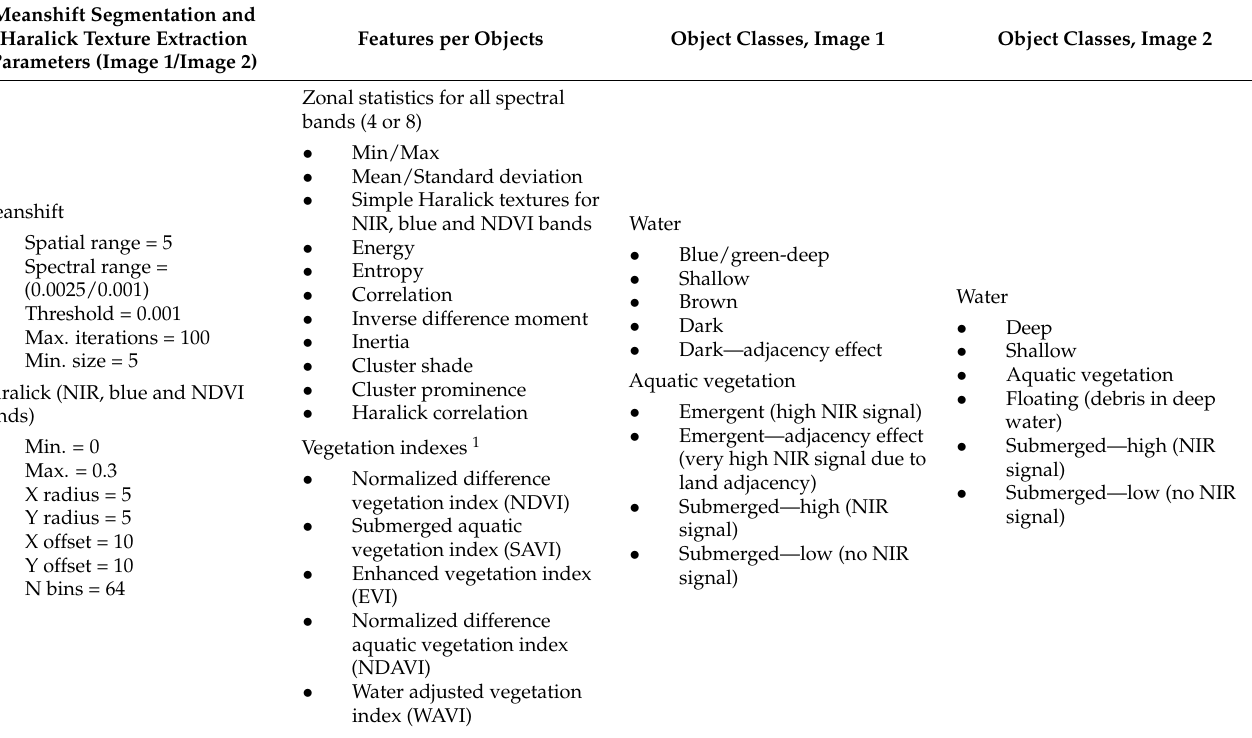
Table 2. Parameters, features and classes used for object-based image analysis level 2 classification (vegetation cover